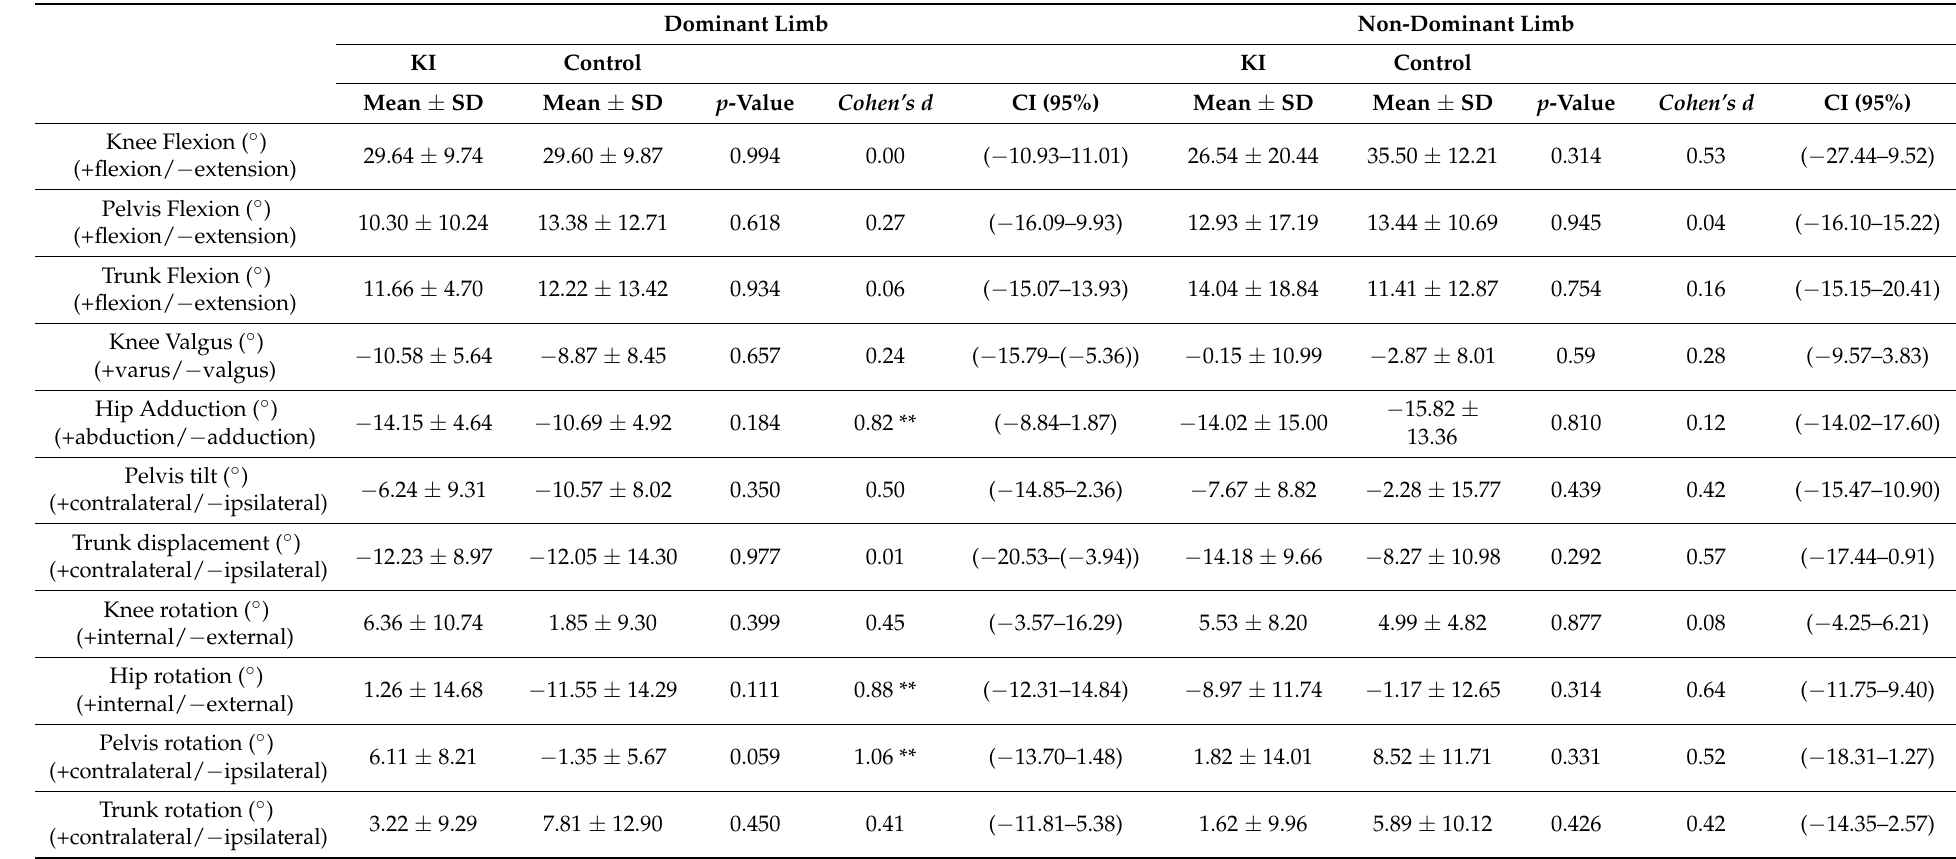
Table 1. Comparative analysis of the kinematic outcomes between KI and control groups in DL and